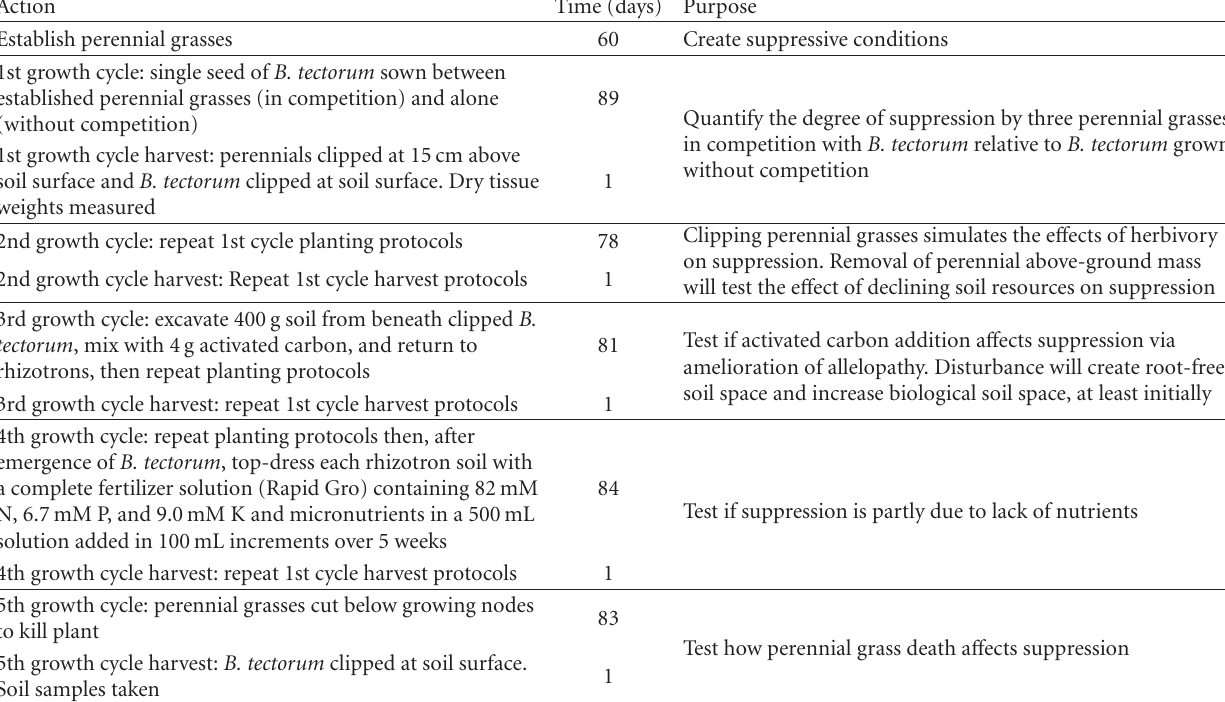
Table 1: Summary and time line of experimental protocols.